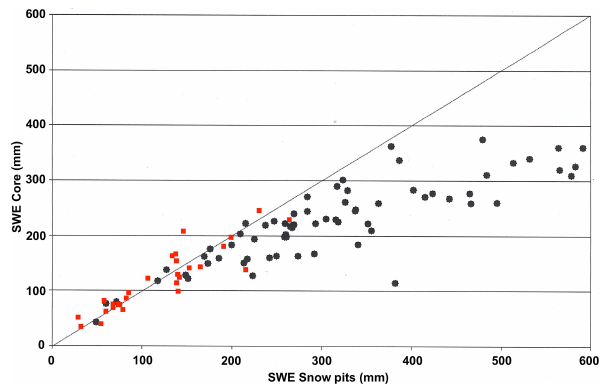
Figure A2. Comparison between SWE measurements (in mm) from snow core and snow pit methods. Red squares are for small- diameter snow cores (ESC-30 type core, 6.2cm), and black points are for large-diameter snow cores (9.5cm). The black line is Y = X . Measured SWE core values are clearly underestimated above 250–300mmw.e.. Unfortunately, no measurements with small-diameter snow cores above 280mmw.e. are present in this example. The database (94 points) is derived from the Interna- tional Polar Year project (Langlois et al., 2010), including sam- pling sites at Sherbrooke (SIRENE; 45.37 ◦ N, 71.92 ◦ W), Sept-Îles (50.30 ◦ N, 66.28 ◦ W), Schefferville (54.90 ◦ N, 66.70 ◦ W) and Ku- ujjuaq (58.06 ◦ N, 71.95 ◦ W) (also see Royer et al.,